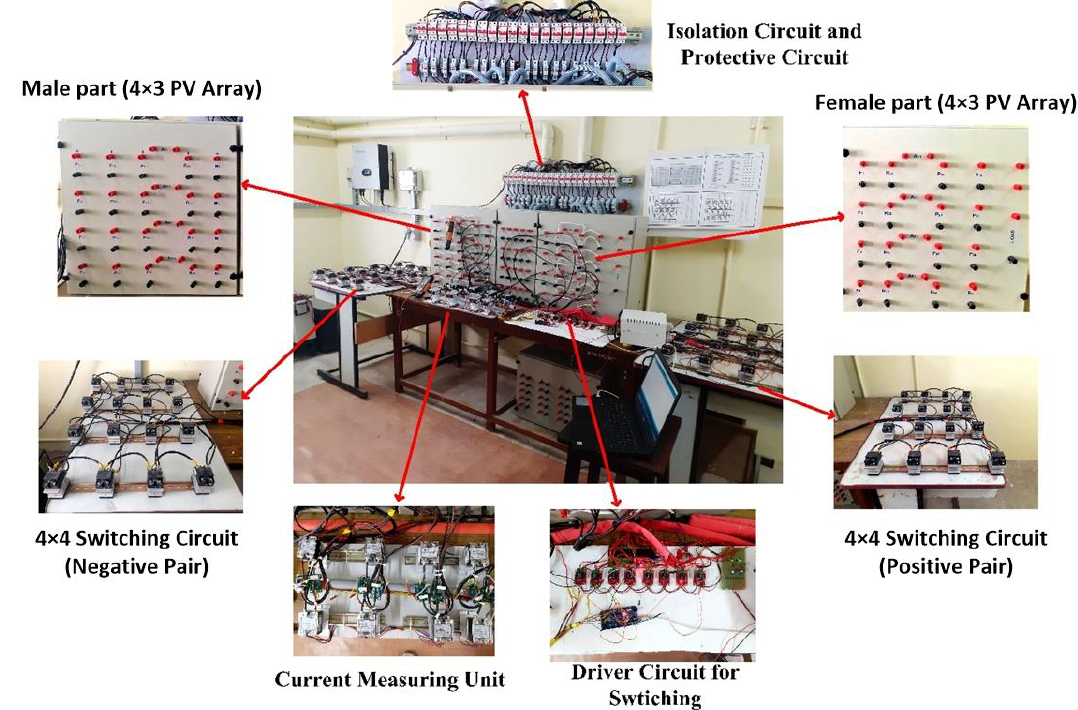
Figure 5. Photograph of the hardware setup.